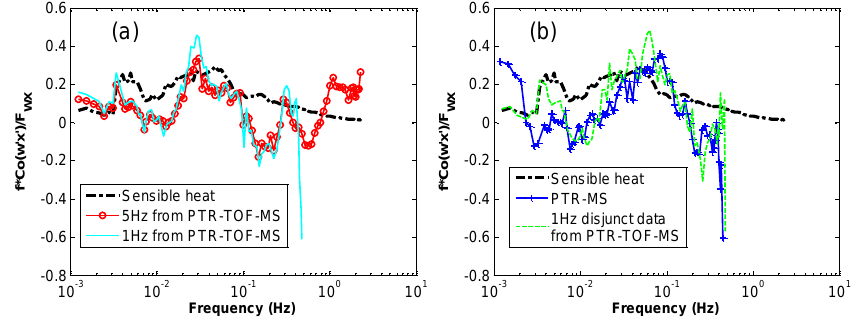
Fig. 7. Normalized co-spectra for vertical wind speed with sensible heat (broken black line) and acetone ( m/z 59.048 for PTR-TOF-MS and m/z 59 for PTR-MS) for 14:00 PST on 22 July, 2010, smoothed by averaging into 100 equally-spaced logarithmic bins. Each line presents the normalized co-spectra of sensible heat flux (broken black line) and acetone flux; (a) original 5 Hz data from PTR-TOF-MS (red line with open circle), 1 Hz reduced data from PTR-TOF-MS (solid cyan line), (b) 1 Hz disjunct sub-sampled (similarly to PTR-MS data acquisition) from PTR-TOF-MS (dotted green line), and ∼ 1 Hz disjunct data from PTR-MS (solid blue line with plus).